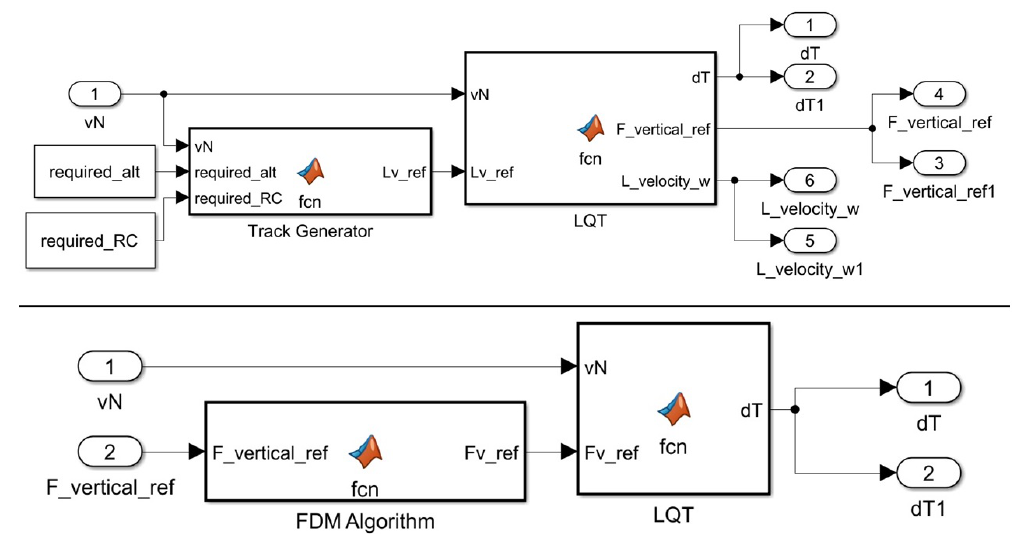
Figure 9. Configuration of altitude control of leader ( top ) and follower ( bottom